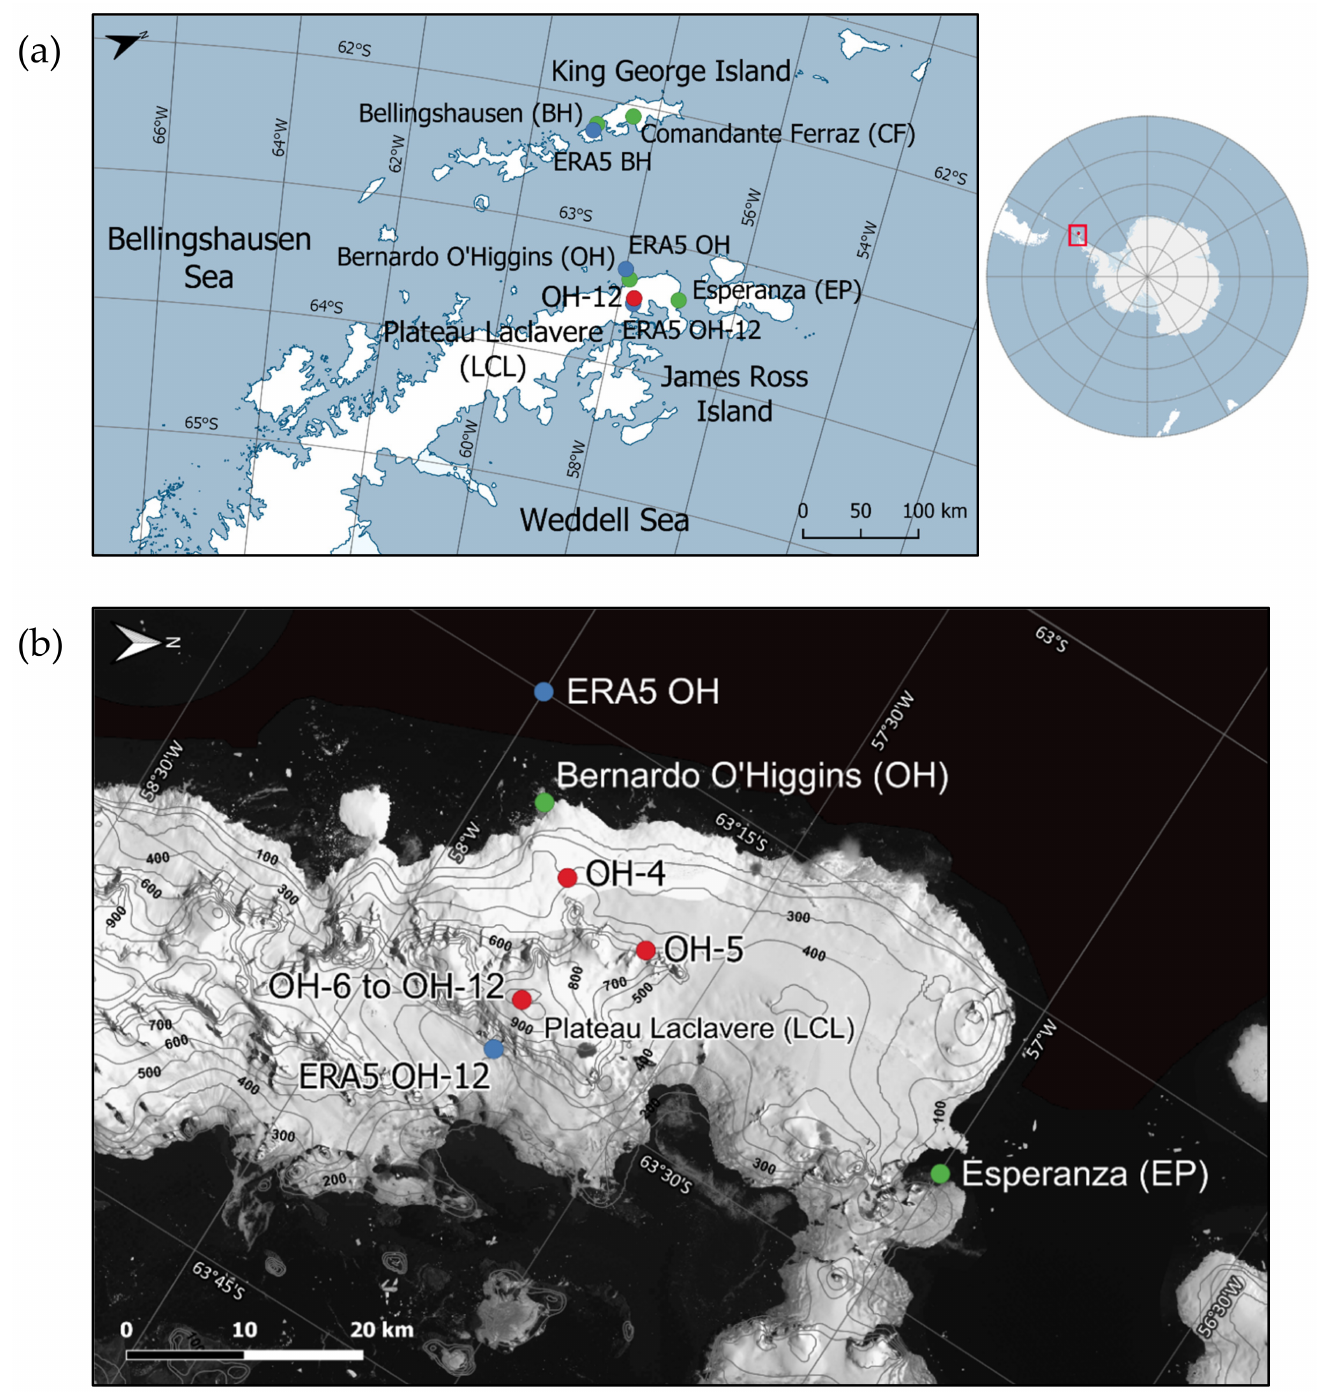
Figure 1. ( a ) Overview of the study area and ( b ) location of the drill sites of all firn cores (OH-4 to OH-12; red dots) retrieved from Plateau Laclavere (LCL) on the northern Antarctic Peninsula between 2008 and 2016. The green dots indicate the location of the Antarctic stations Bernardo O’Higgins (OH), Bellingshausen (BH), Esperanza (EP) and Comandante Ferraz (CF). The blue dots mark the location of the ERA5 grid points closest to BH and OH stations as well as to the OH-12 drill site on LCL. Coordinates and altitudes of OH, BH, EP and CF stations and the OH-12 drill location on LCL are given in Supplementary Table